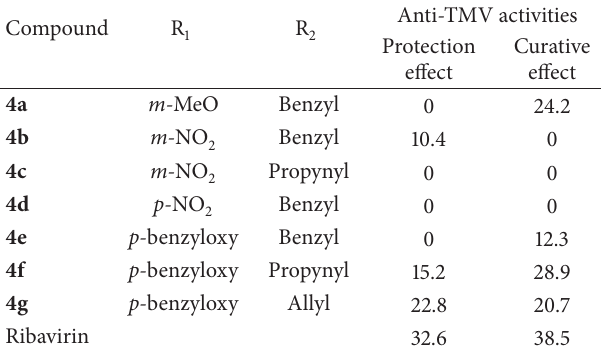
Table 1: Antiviral activities of the title compounds at 500 𝜇 g/mL.